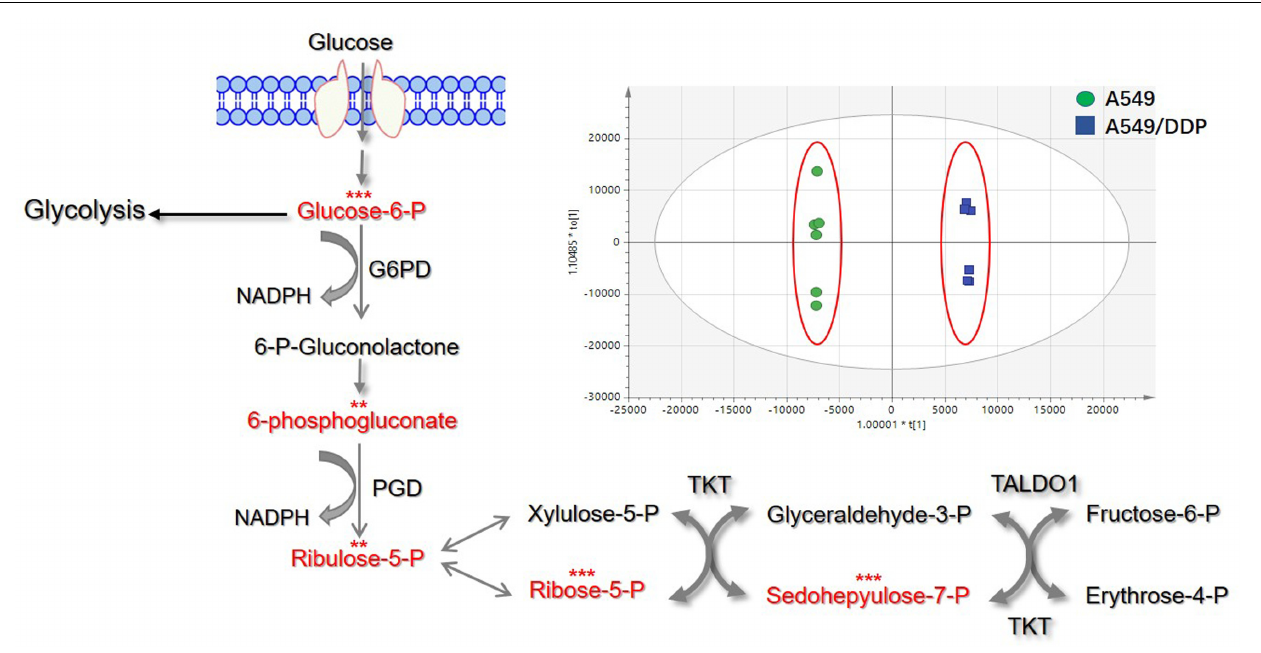
FIGURE 1 | Principal component analysis (PCA) analysis of large polar metabolites and differences in PPP relative metabolites between A549 and A549/DDP cells. The red font represents the differential metabolites. Significant differences are indicated as ∗ P < 0.05, ∗∗ P < 0.01, and ∗∗∗ P < 0.001.